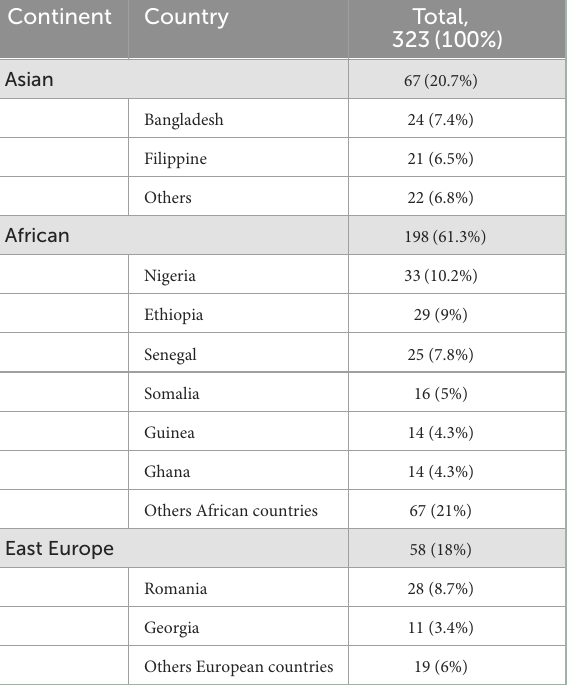
TABLE 4 Top ten countries origin of migrant with